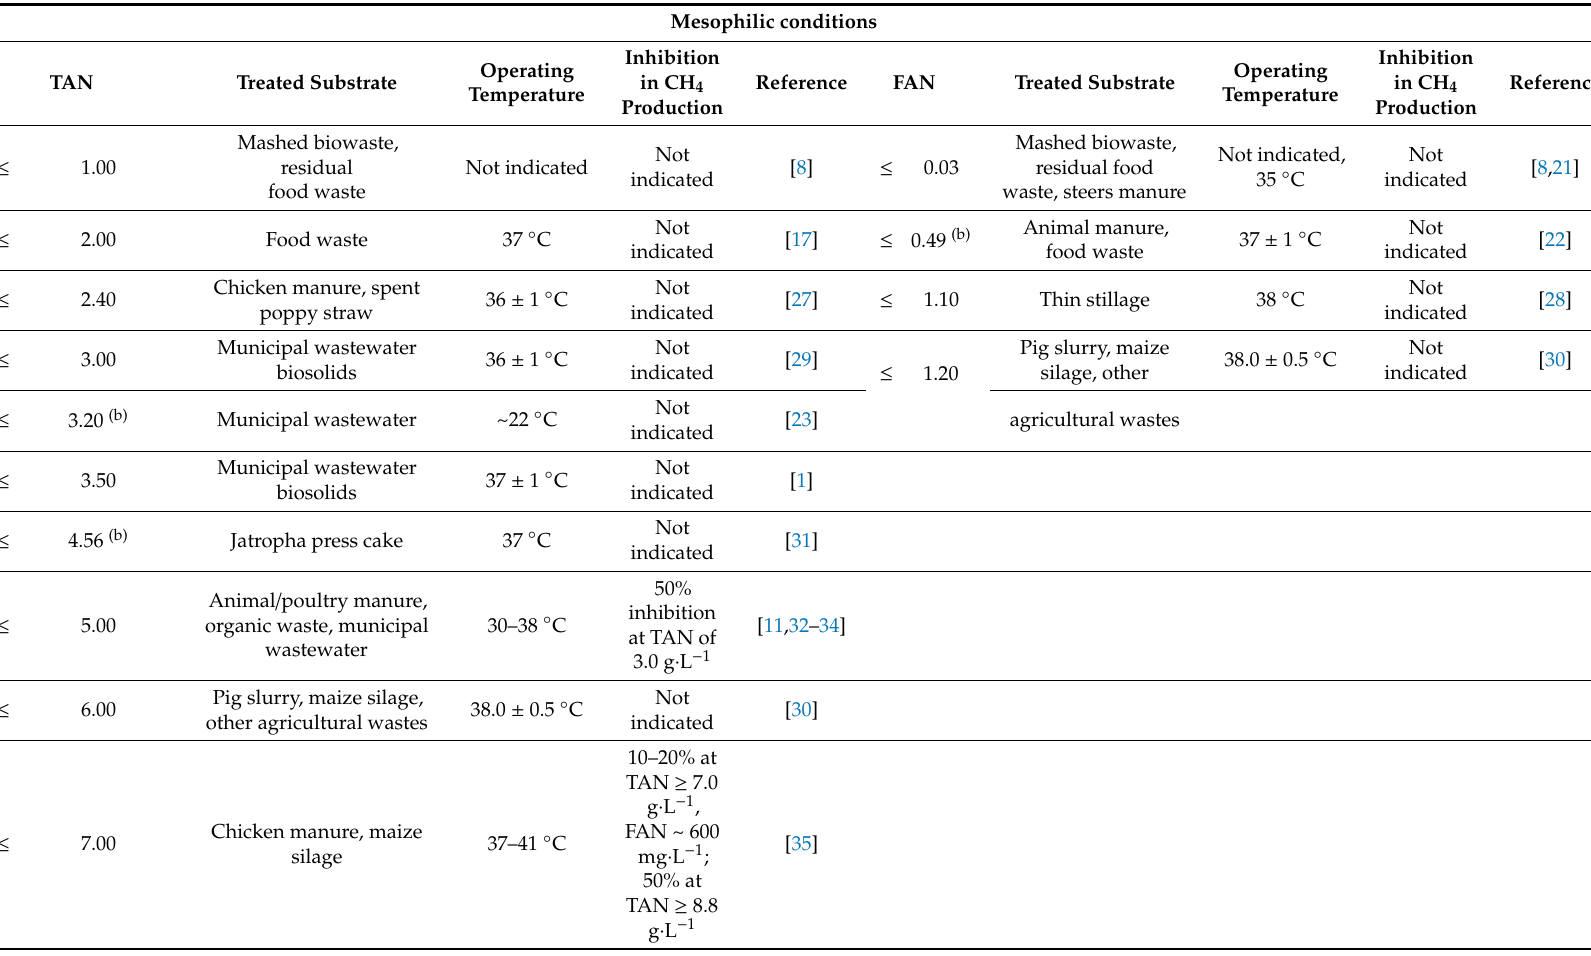
Table 1. Limiting total ammonia nitrogen (TAN)- and free ammonia nitrogen (FAN)-concentrations (g · L − 1 ) for maintaining stable anaerobic digestion (AD) under di ff erent temperature